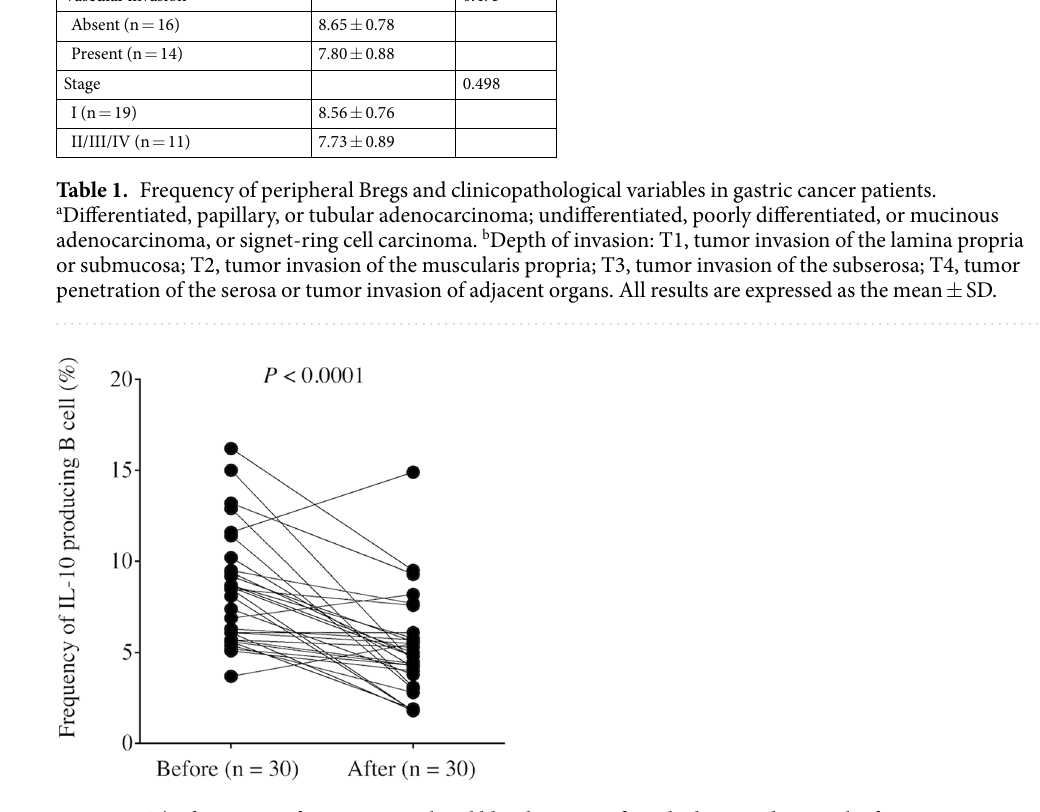
Figure 2. The frequency of Bregs in peripheral blood was significantly decreased 1 month after surgery compared with before the operation ( P <